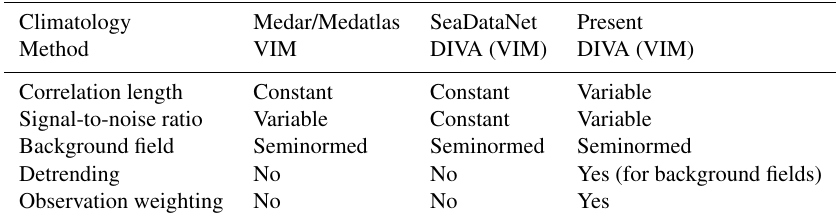
Table 2. Analysis parameters for variational inverse method (VIM) implementation in the